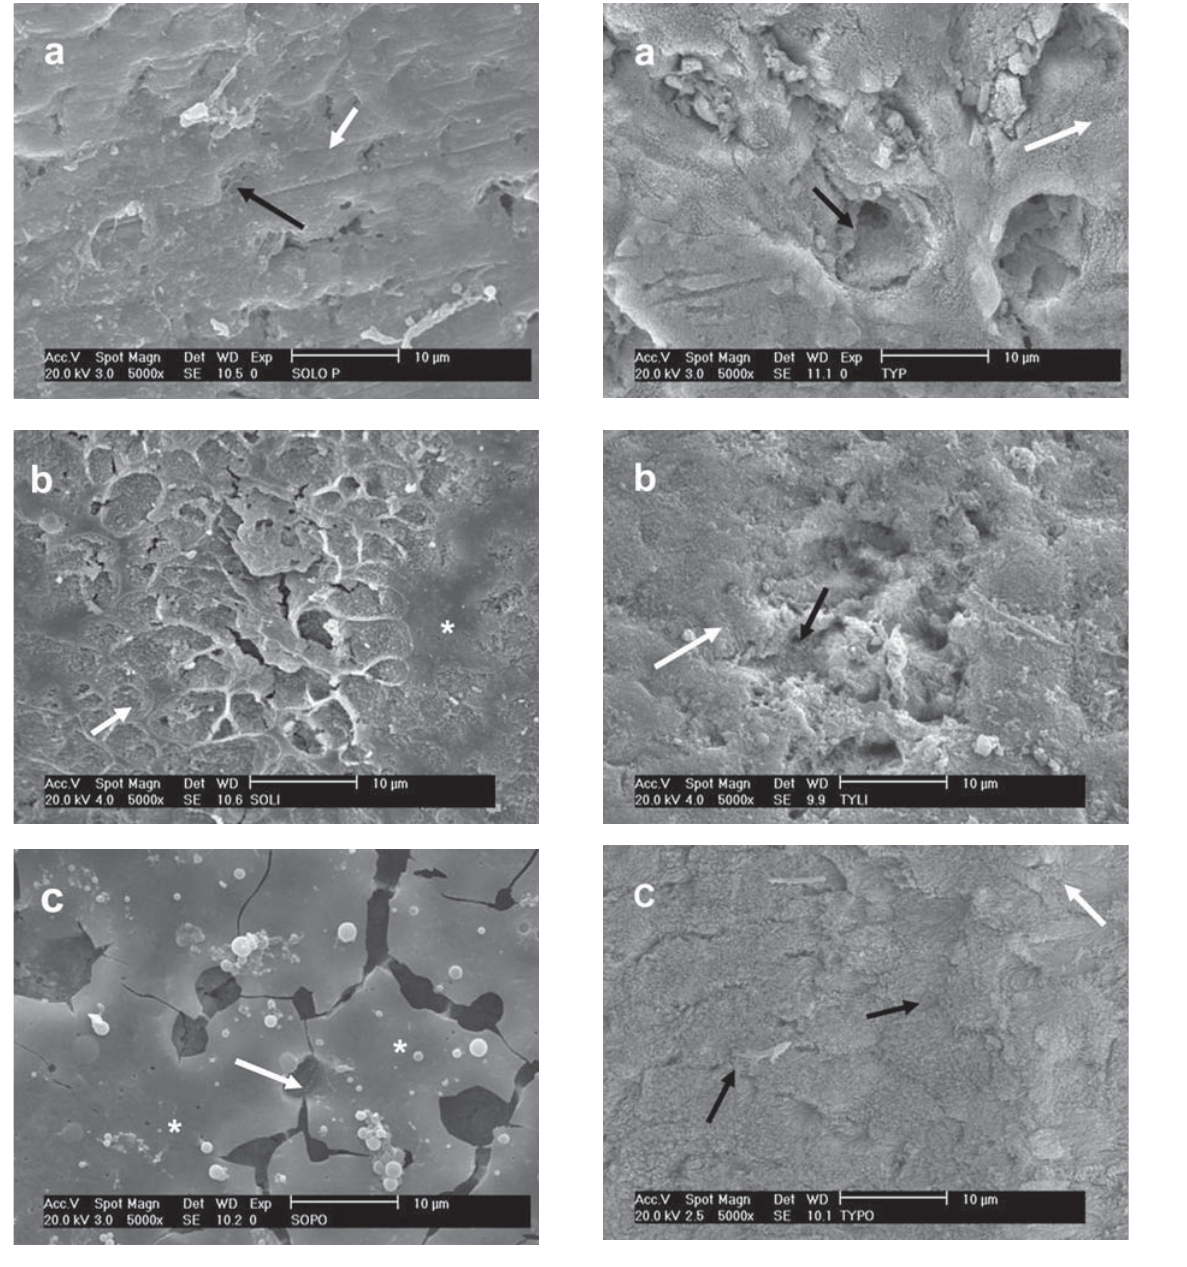
FIGURE 6- SEM micrograph of different enamel treated- groups following treatment with OptiBond Self-etching primer. a – Prophylaxis: Small grooves (white arrow) can be identified. Shallow depressions are presented in a predominantly flat surface (black arrow); b – SiC treatment: Shallow-wide depressions (white arrow) and unetched areas (white asterisk) are predominant. Narrow and deep depressions (black arrow) are dispersed within shallow demineralized areas; c - Diamond bur: Note a cracked smooth surface (white asterisk) with remaining self-etching primer and deep and wide depressions (white arrow) showing the effect of the self-etching primer on the treated enamel surface